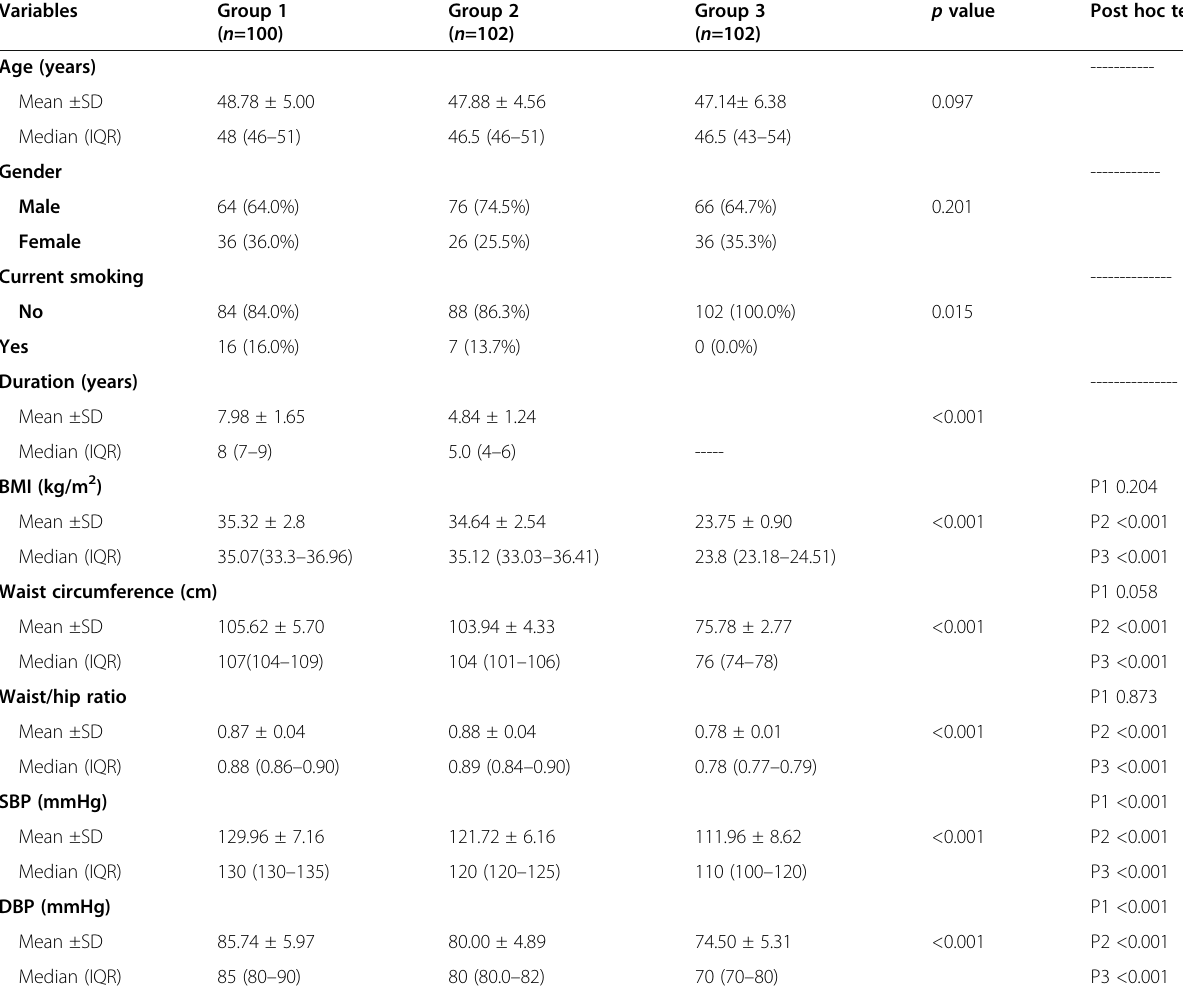
Table 1 Demographic and clinical data of the studied groups